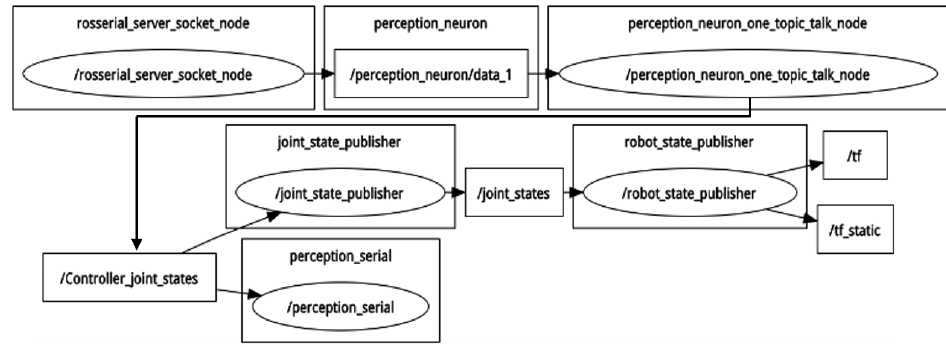
Figure 3. Visualized data stream through ROS publish_subscribe messaging.